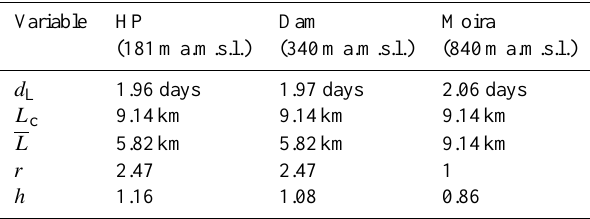
Table 9. Estimates of the average lifetime of rainfall features, d L , the average sampling length, ( L ) (see Eqs. 15 and A.3), and the res- olution r (see Eq. 12), for locations A (HP), B (dam) and C (Moira); see Fig. 2. The last row of the table shows estimates of the inter- annual multiplicative correction factor obtained from Eq. (21).